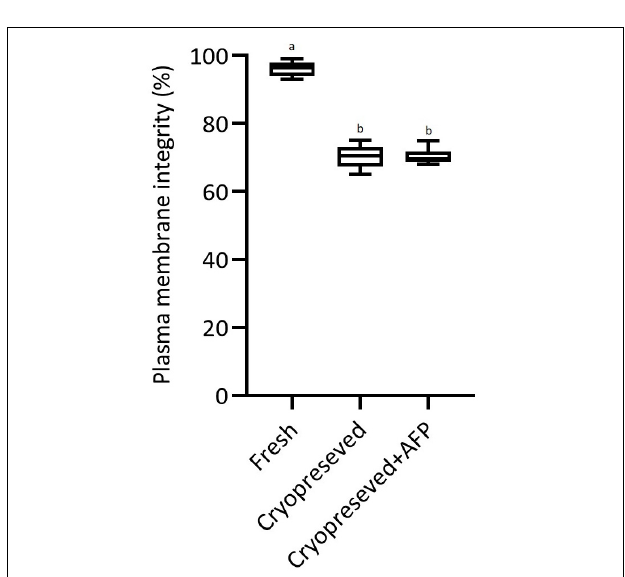
FIGURE 2 | Effect of cryopreservation on plasma membrane integrity in fresh, cryopreserved, and cryopreserved spermatozoa with supplementation of 10 µ g/mL AFPI (cryopreserved + AFP) in sterlet. Values with different lower-case letters are significantly different [ p < 0.05, one-way analysis of variance (ANOVA) followed by Tukey’s honest significant difference